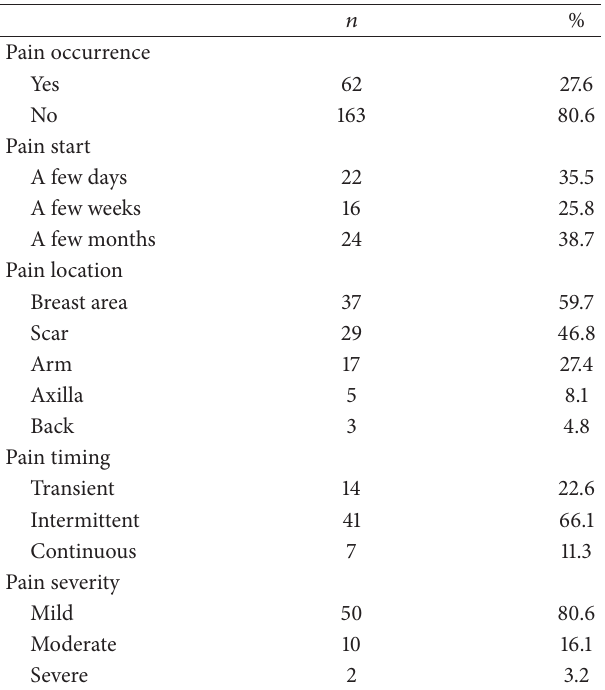
Table 1: Pain characteristics.